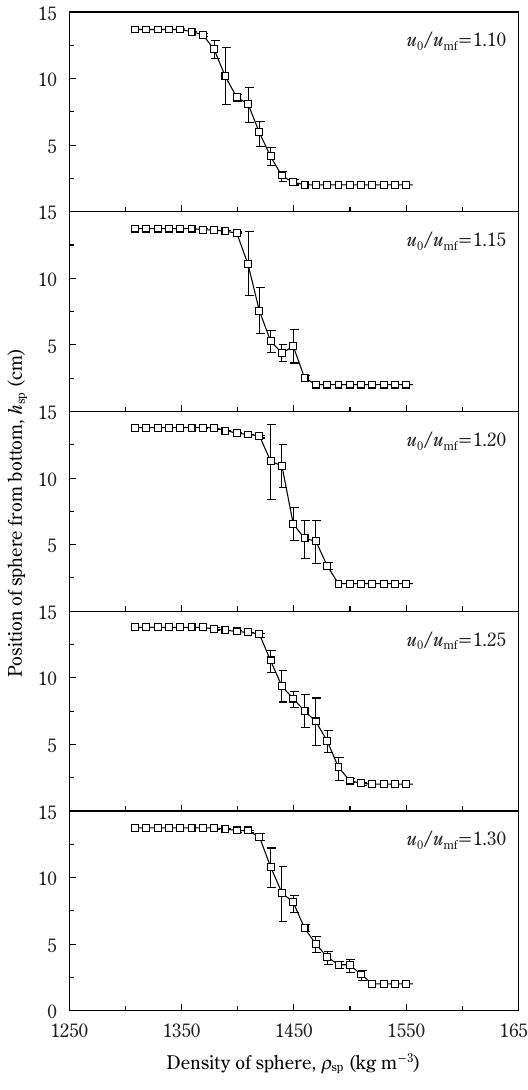
Fig. 8 Dependence of sphere position on density at various super- ficial velocities. Powder is glass beads.